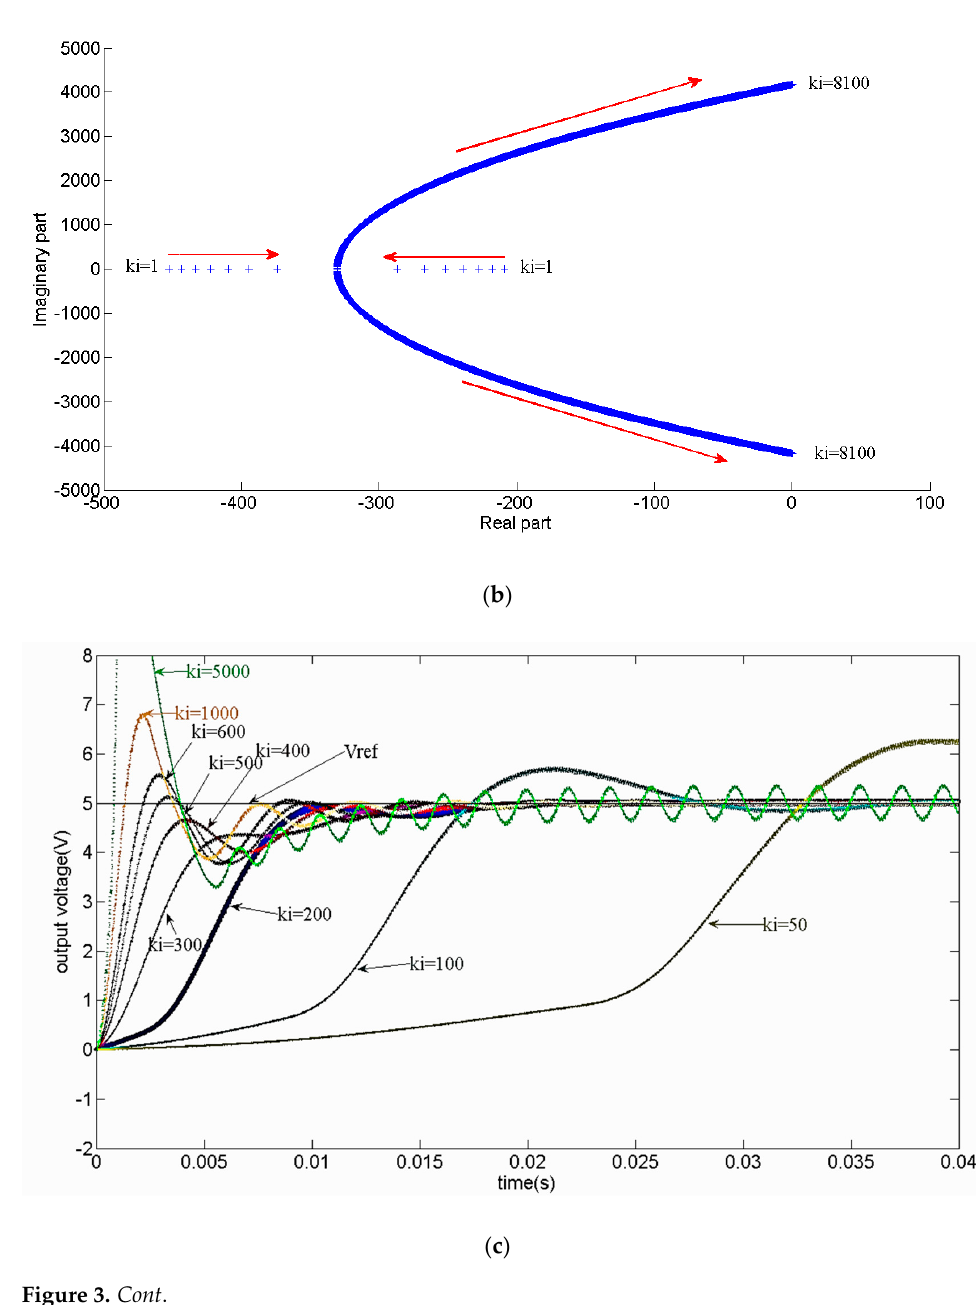
Figure 3. Characteristic equation roots and output voltage of the closed-loop controller for di ff erent controller gains. ( a ) Characteristic equation roots during charges of 𝑘 ( 𝑘 (cid:3010) = 200 ); ( b ) characteristic equation roots during charges of 𝑘 (cid:3010) ( 𝑘 = 200 ); and ( c ) step response of proposed PSMC for di ff erent values of 𝑘 (cid:3010) at the start − up